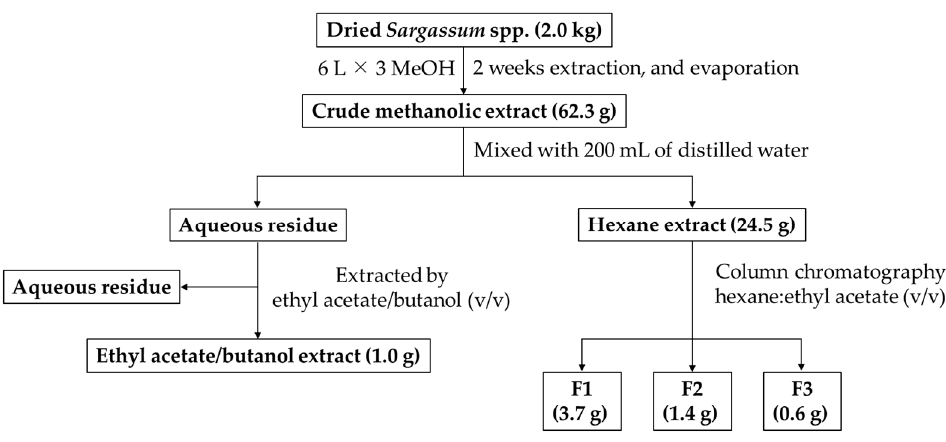
Figure 2. Extraction and isolation process of bioactive constituents from Sargassum spp.